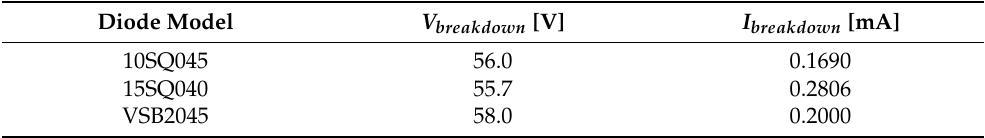
Table 6. Reverse breakdown voltages and currents for the three